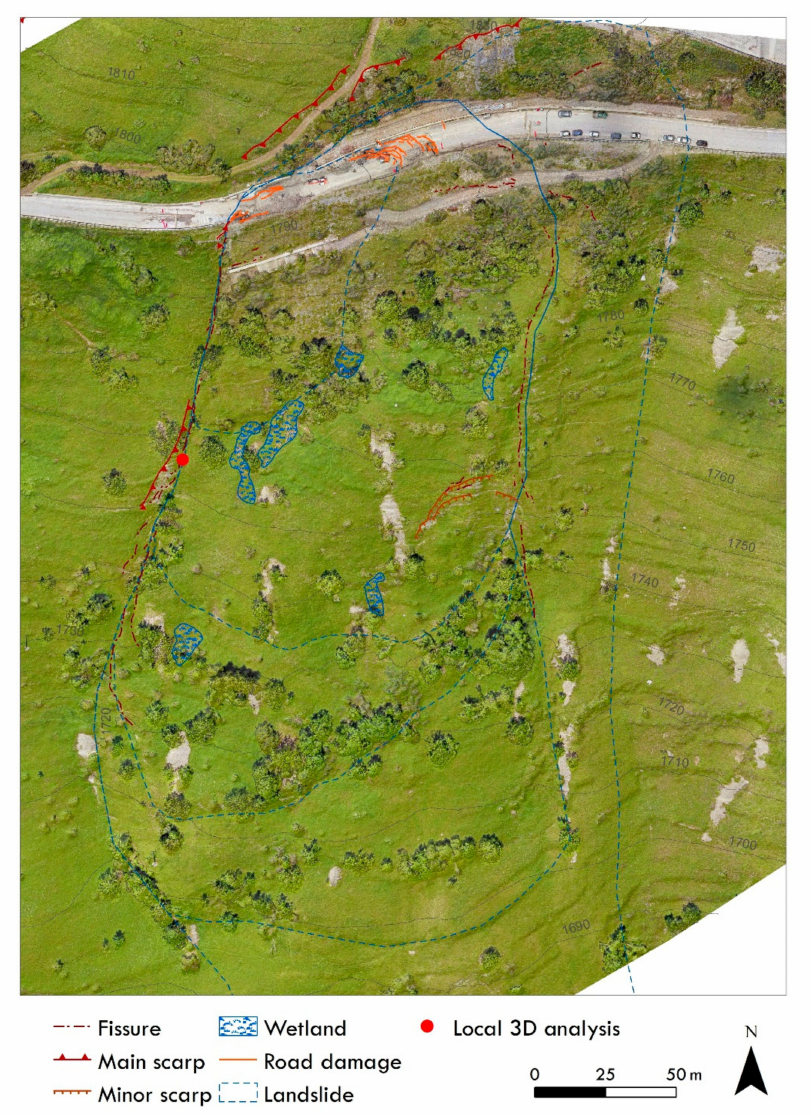
Figure 8. Map of the geomorphological evidence of the unstable area (Orthophoto source: 14 June 2018 UAV